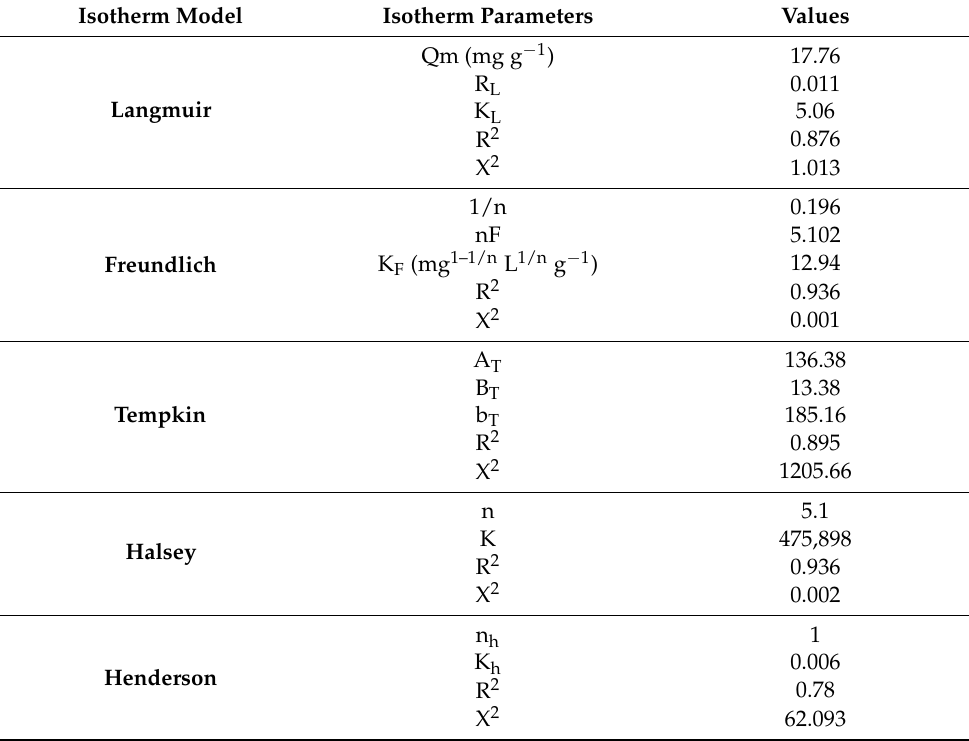
Table 4. Factors of the isotherm models from linear